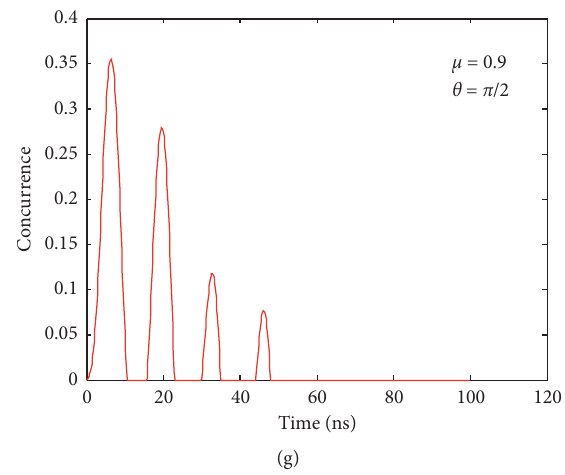
Figure 4: Time evolution of the concurrence for different purity of the initial